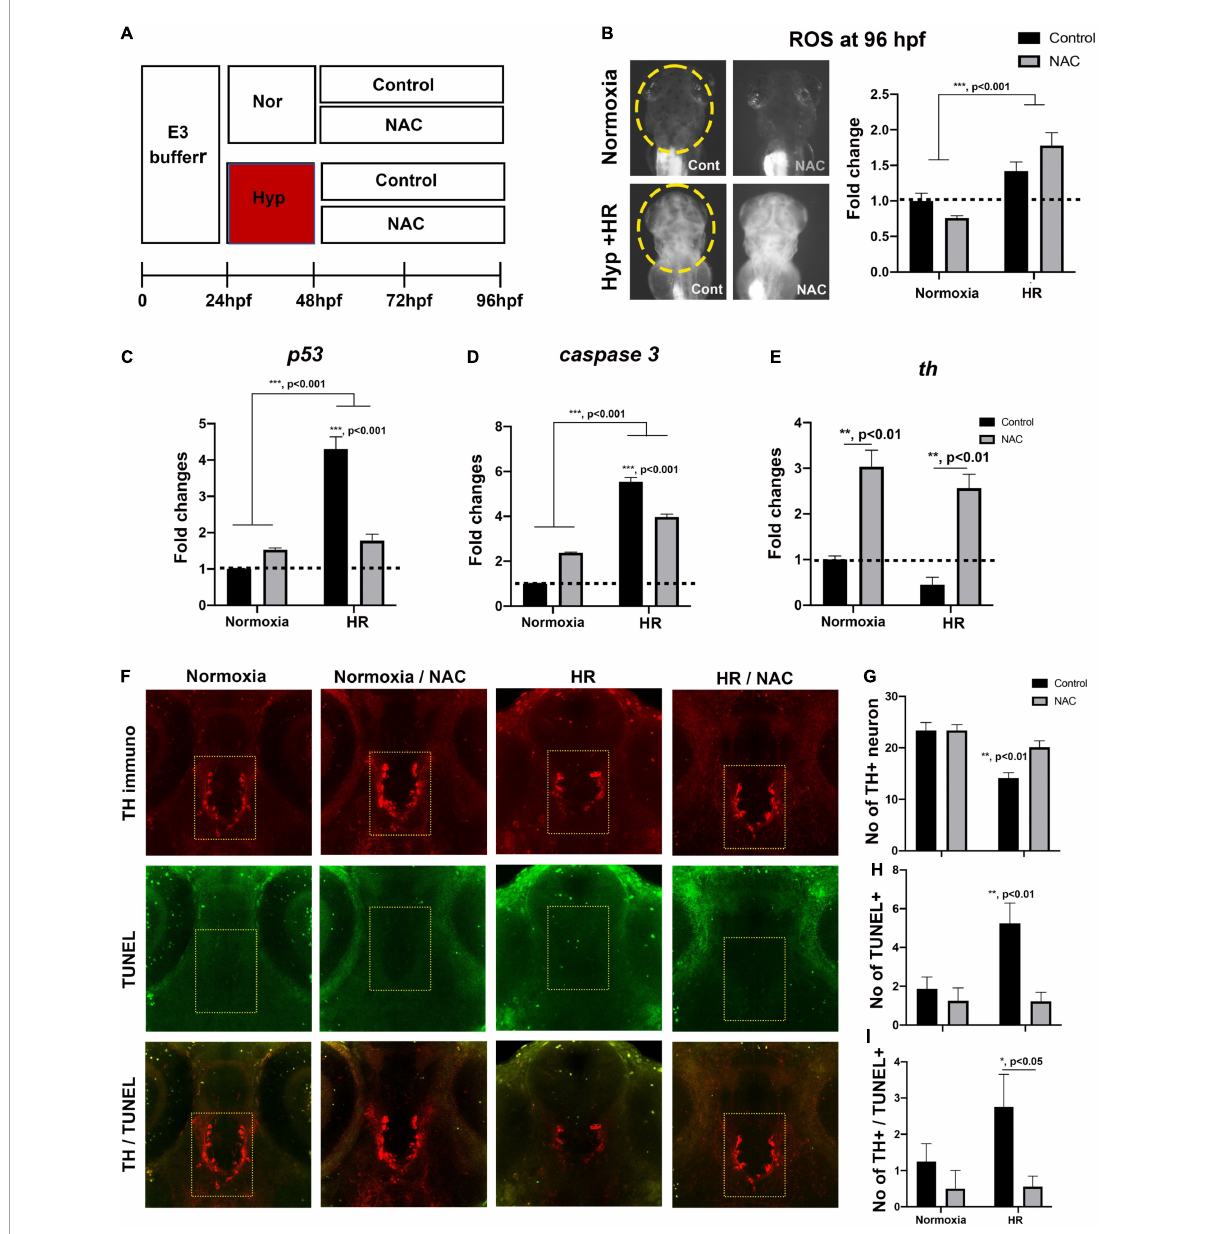
FIGURE5 (A) A schematic diagram for NAC treatment procedures by HR and the effects of NAC with reoxygenation against the hypoxic injury with HR 96 hpf. (B) ROS production/accumulation in zebrafish head at 96 hpf in normoxic control ( n = 16), normoxic NAC ( n = 17), HR control ( n = 14), and HR NAC ( n = 14) analyzed by two-way ANOVA followed by Tukey’s post hoc test and presented fold changes compared to normoxic control. (C–E) Different expression of proapoptotic genes ( p53, caspase9, caspase3 , and bax ) by HR, including HR NAC ( n = 6/group, triplicated) and HR control ( n = 6/group, triplicated), normoxic NAC ( n = 6/group, triplicated), and normoxic control ( n = 6/group, triplicated) analyzed by two-way ANOVA followed by Tukey’s post hoc test and presented by percent changes. (F) The Z-stack, confocal images of TUNEL + and